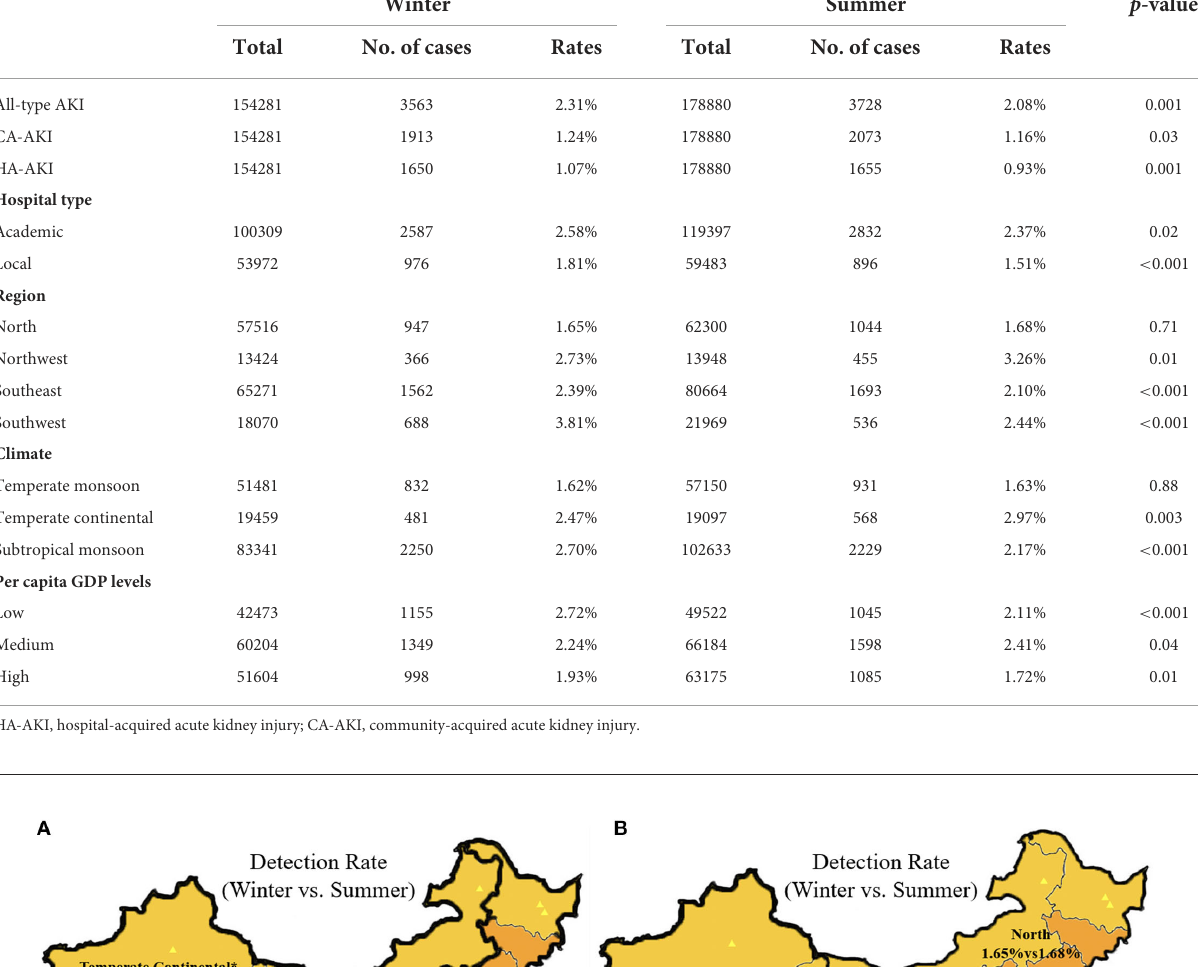
TABLE 1 Comparison of detection rates in patients with different seasons.